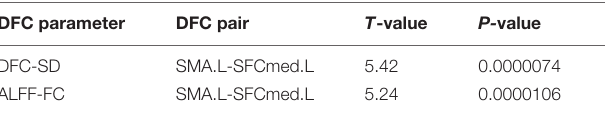
TABLE 3 | Comparisons of temporal variability between chronic tinnitus patients before acupuncture and normal subjects.